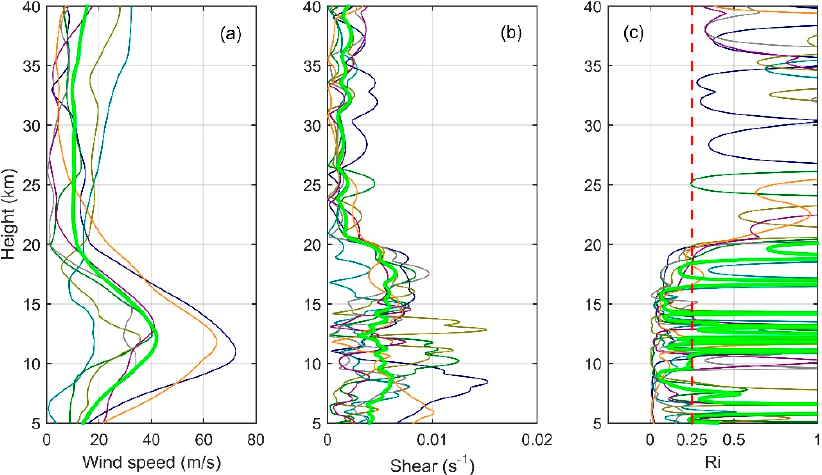
Figure 6. Wind profiles ( a ); windshear profiles ( b ); and Ri profiles ( c ) obtained from ERA-Interim data.